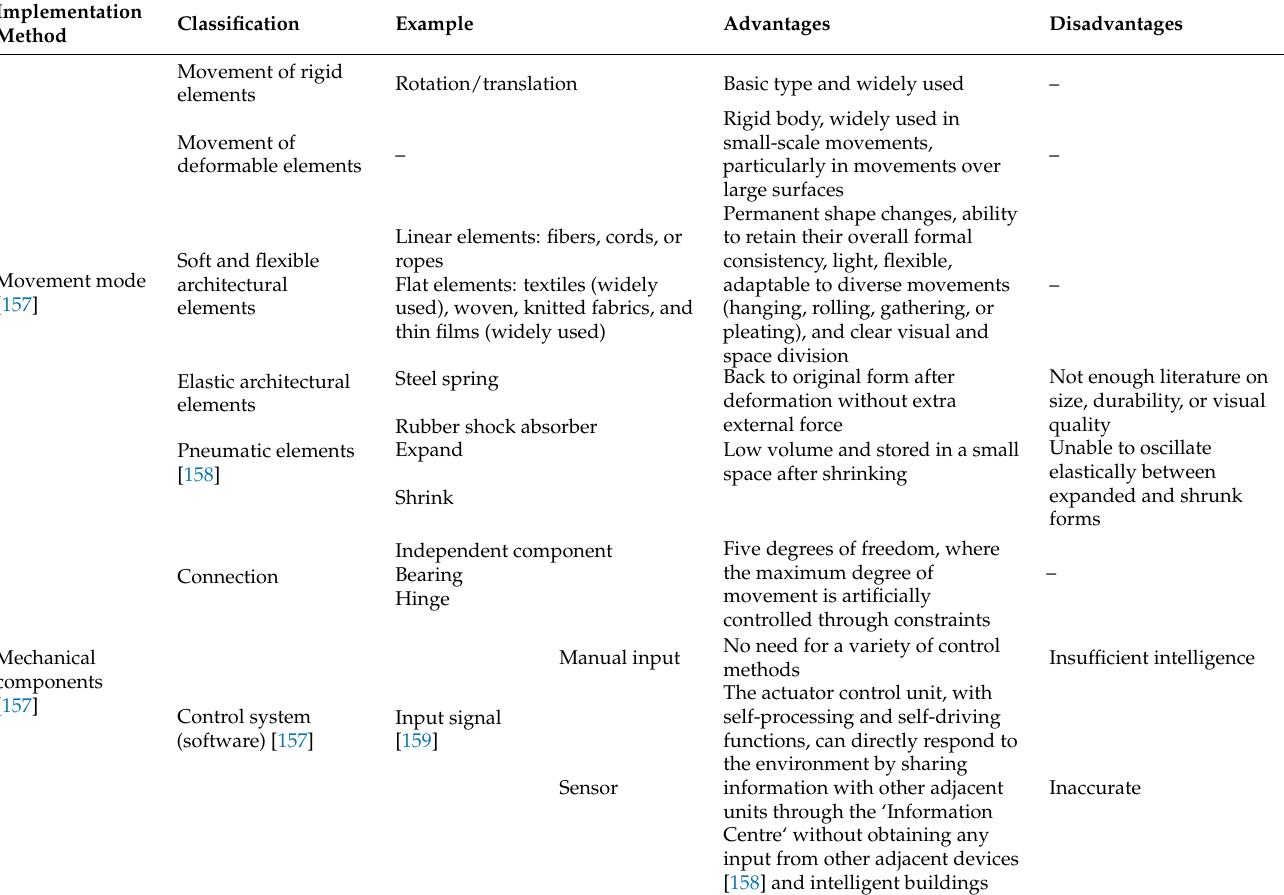
Table 8. Control implementation